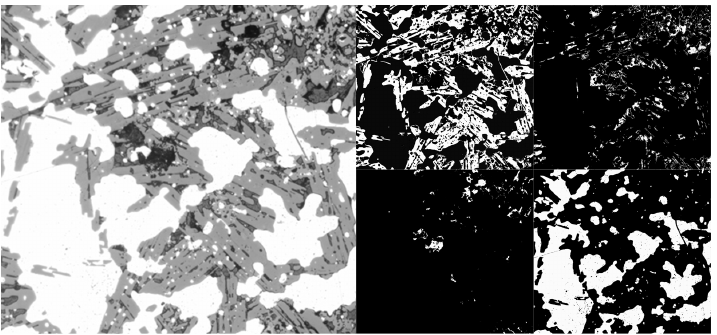
Figure 4. ( Left ) A LOM picture. ( Right ) extraction of four phases from the LOM figure using image